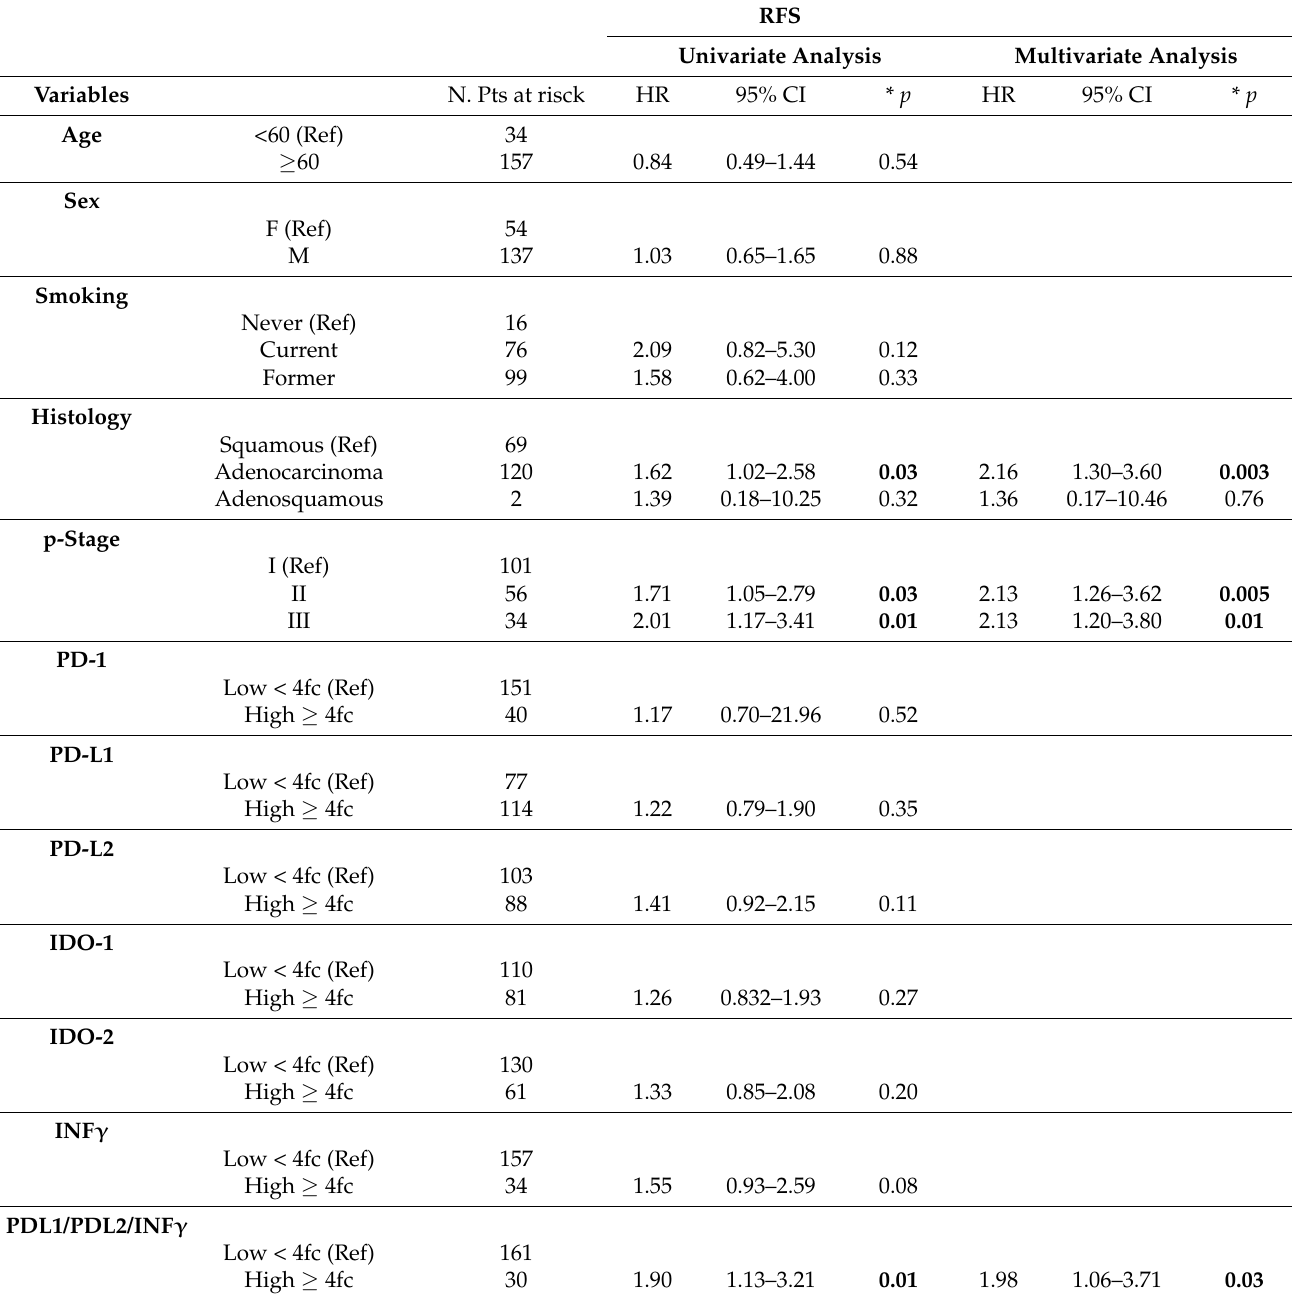
Table 3. Univariate and multivariate analyses for recurrence-free survival